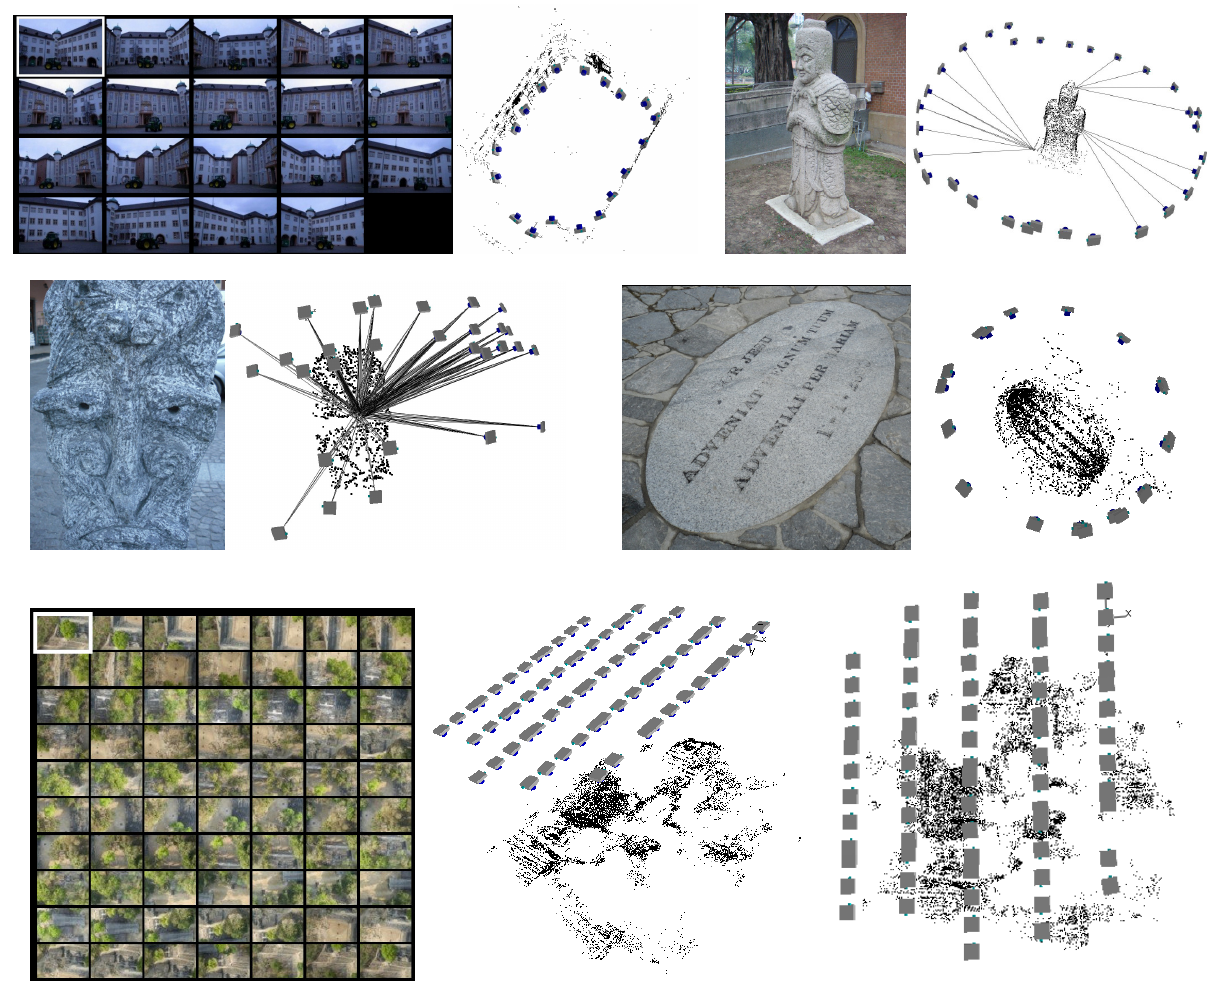
Figure 1: Examples of ordered sequences and sparse blocks oriented with a photogrammetric bundle adjustment using a set of tie points automatically extracted and matched via feature-based